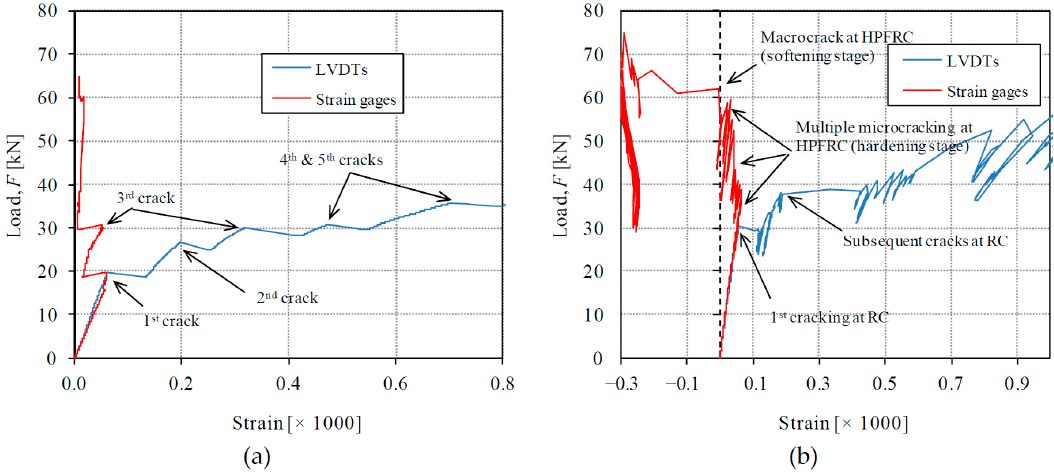
Figure 10. Comparison of local and global measurements with the help of strain gauges and LVDTs, respectively: ( a ) RC specimen T0; ( b ) Composite RC-HPFRC specimen T1.